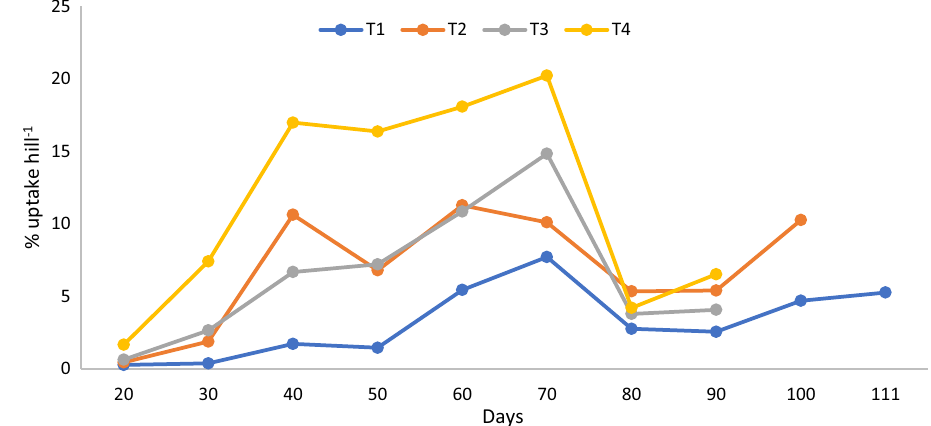
Figure 5. Chicken litter biochar on total nitrogen uptake of MR219 rice plants cultivated on a tropical acid